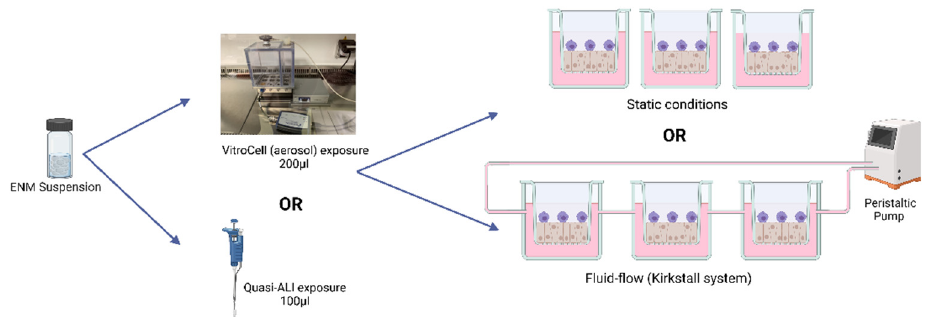
Figure 1. Exposure scenarios used. An exposure of an ENM is completed and analysed 24 h after exposure via either the quasi-ALI exposure or the VitroCell (aerosol) exposure method. Cultures are either in static conditions or under fluid-flow conditions using a peristaltic pump and the Kirkstall QuasiVivo TM exposure system. All exposures equate to the same deposited exposure concentration regardless of the exposure scenario chosen. Cells are maintained at 37 °C and 5% CO 2 . Created with BioRender.com (accessed on 20 July